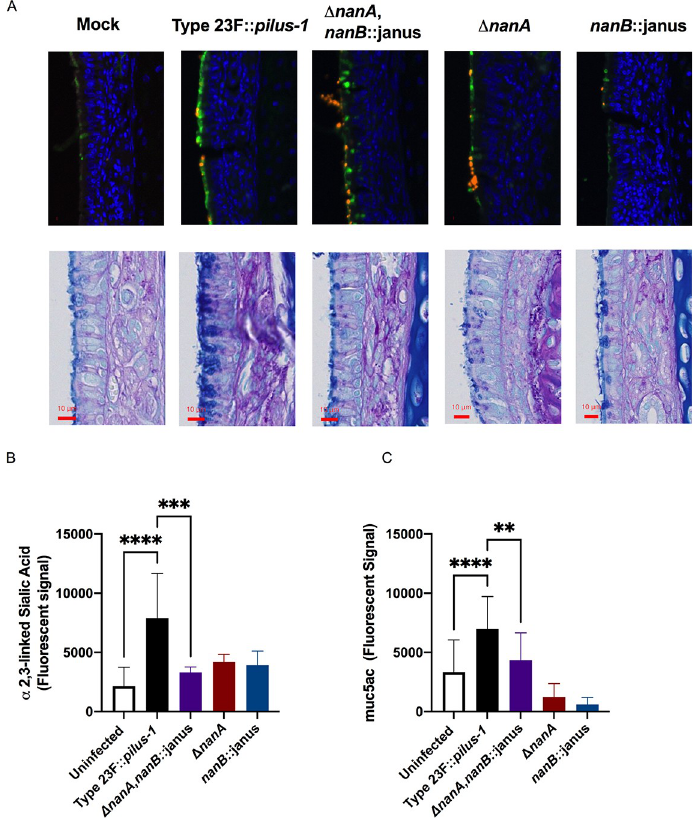
Fig 7. Spn neuraminidases stimulate mucus containing secretions in a neuraminidases-dependent manner. (A) URT tissue sections of mock- or Spn-infected infant mice were examined at day 5 post-infection. Sialic acid containing secretions were visualized through a SNL lectin staining that detects α -2,6 linked sialic acid (upper row), where green staining indicates sialic acid containing material and orange staining indicates Spn; or alcian blue-PAS staining for mucopolysaccharides (lower row). (B-C) To quantify sialic acid and mucus containing secretions in the URT of mice, retro-tracheal lavages were obtained from infant mice at day 5 p.i.. Immunoblots were performed with the lavages to determine the amount of α -2,3 linked sialic acid (B) or muc5ac mucin (C) . Experiments were performed in duplicates and mean values of three independent experiments are shown with error bars corresponding to S.D., � ,p < 0.05 �� , p < 0.01, ��� ,p < 0.001 by 1-way ANOVA followed by Dunnett’s multiple comparison